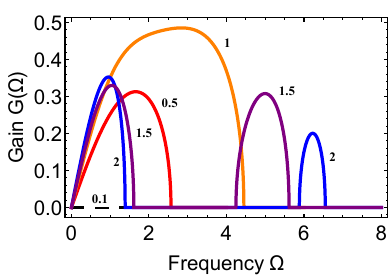
Figure 13. The MI gain spectra for different values of the asymmetry ratio, η , of the CW state (see Equation (8)), which are indicated near the figures, in the mixed-GVD coupler ( α < 0) for P = 0.5, κ = 1.1, α = − 0.1, Γ = 2 with ρ = 0.01.